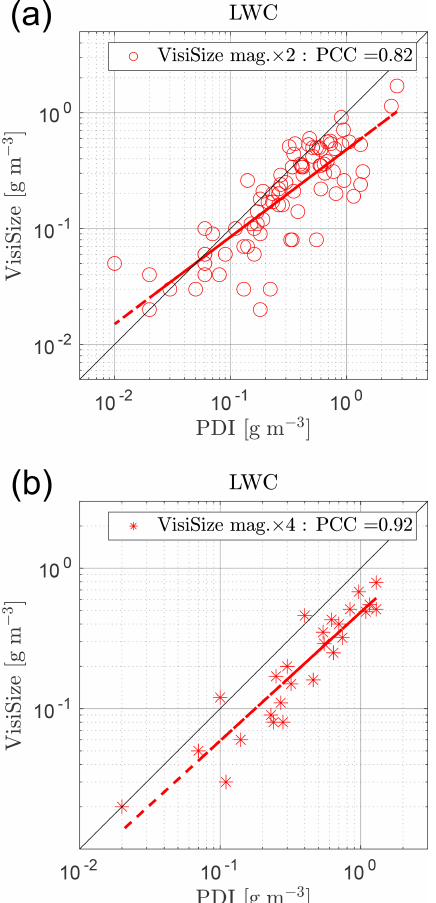
Figure 14. The LWC comparison between the two instruments, with cases using different lens magnification settings for the Vi- siSize ( a : × 2 and b : × 4), plotted separately. The results after ap- plying all modifications and filters to the data, and application of the PVC factor to the modified swept volume method of the PDI, are shown here. Each circle/star represents a single measurement of ∼ 15min. Dashed red lines show the LSR, and the PCC is shown in the legend.